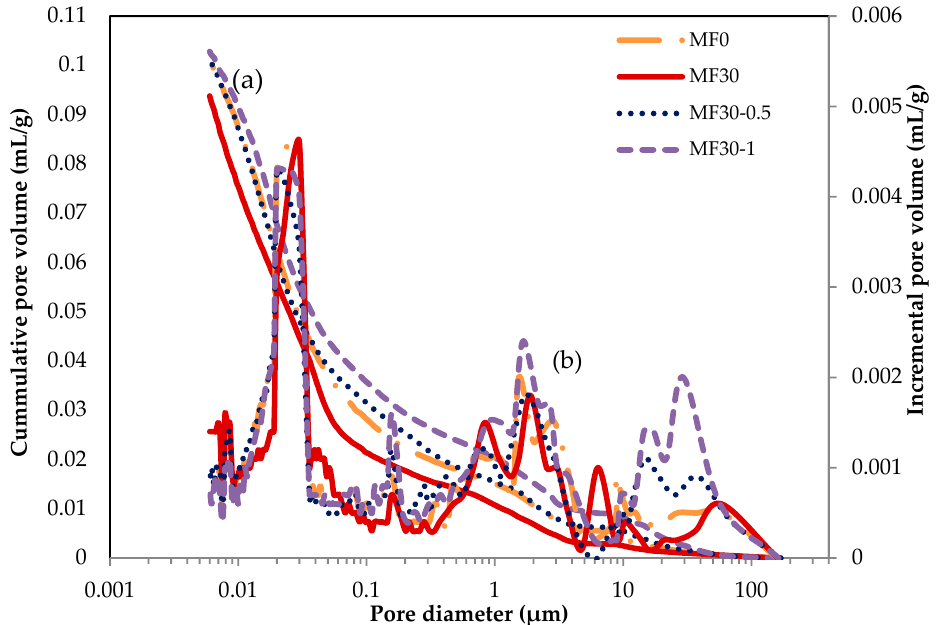
Figure 13. (a) Cumulative and (b) incremental pore volume curves of concrete mixes (MF0, MF30, MF30-0.5, and MF30-1).